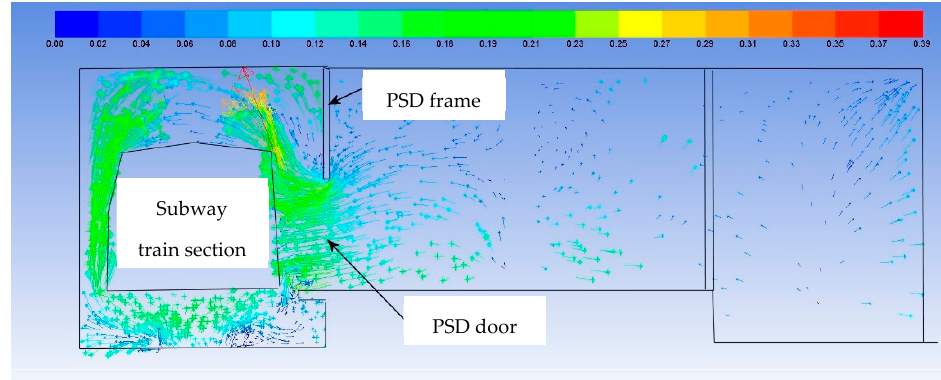
Figure 25. Air velocity vectors (m/s)—cross section through the door of the PSD system near the fire outbreak (minute 20).